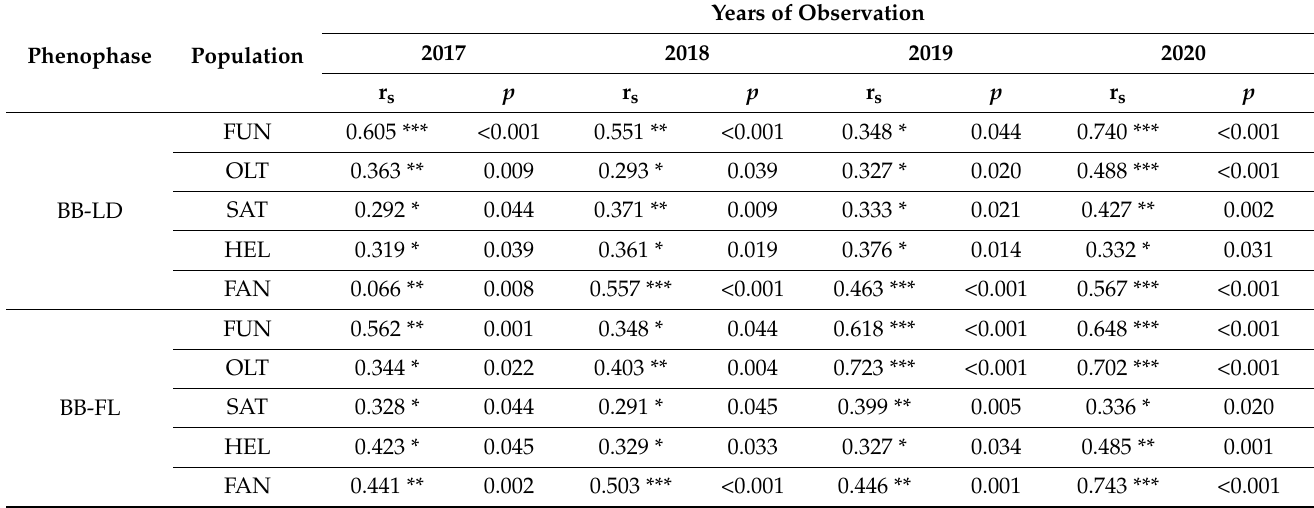
Table 9. Correlations between phenophases based on the recorded phenological